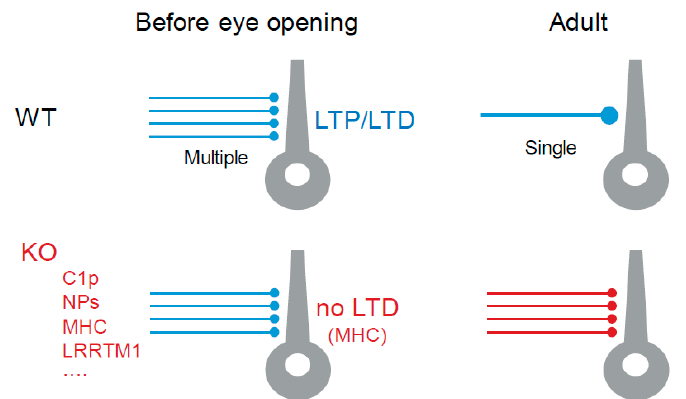
Figure 4. Molecular mechanisms of plasticity in subcortical visual areas. Top, in WT animals before eye opening, thalamocortical neurons are fed by multiple and weak retinal inputs, while in WT adult animals retinal inputs are strong and reduced (refinement). Note that LTP and LTD can be induced at an immature stage. Bottom, in KO animals for proteins involved in synaptic pruning (C1p, NPS, MHC, LRRTM1, and others), no synaptic refinement occurs. Note that LTD is prevented in MHC KO.